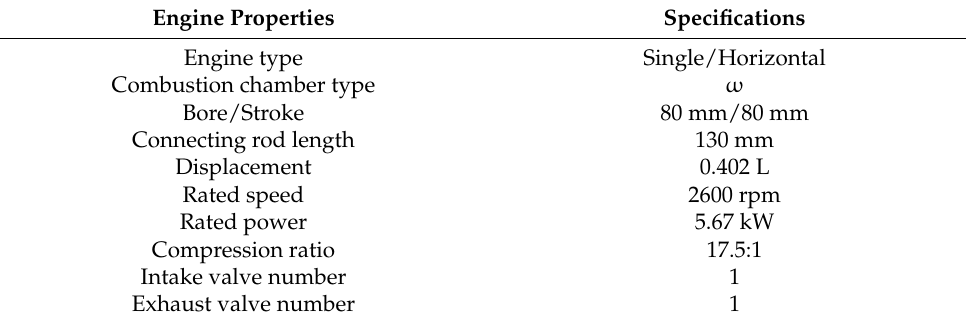
Table 1. The diesel engine